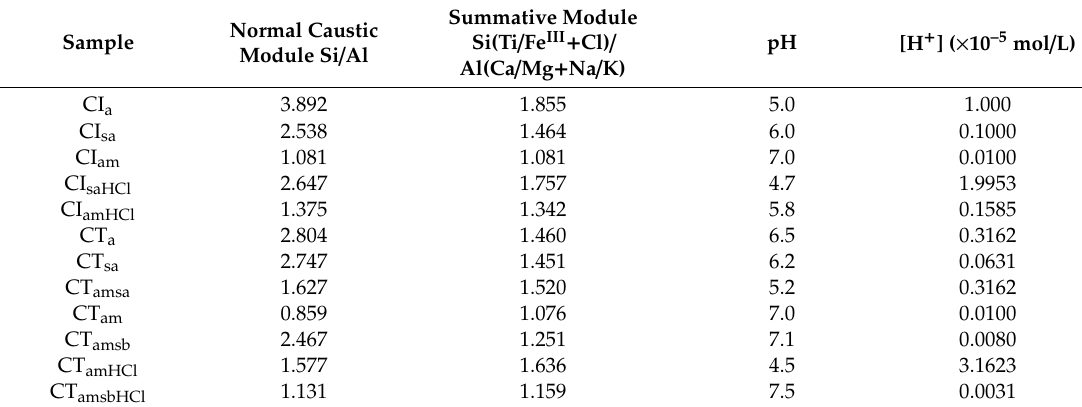
Table 2. Correlation between the normal caustic and summative modules, and the free